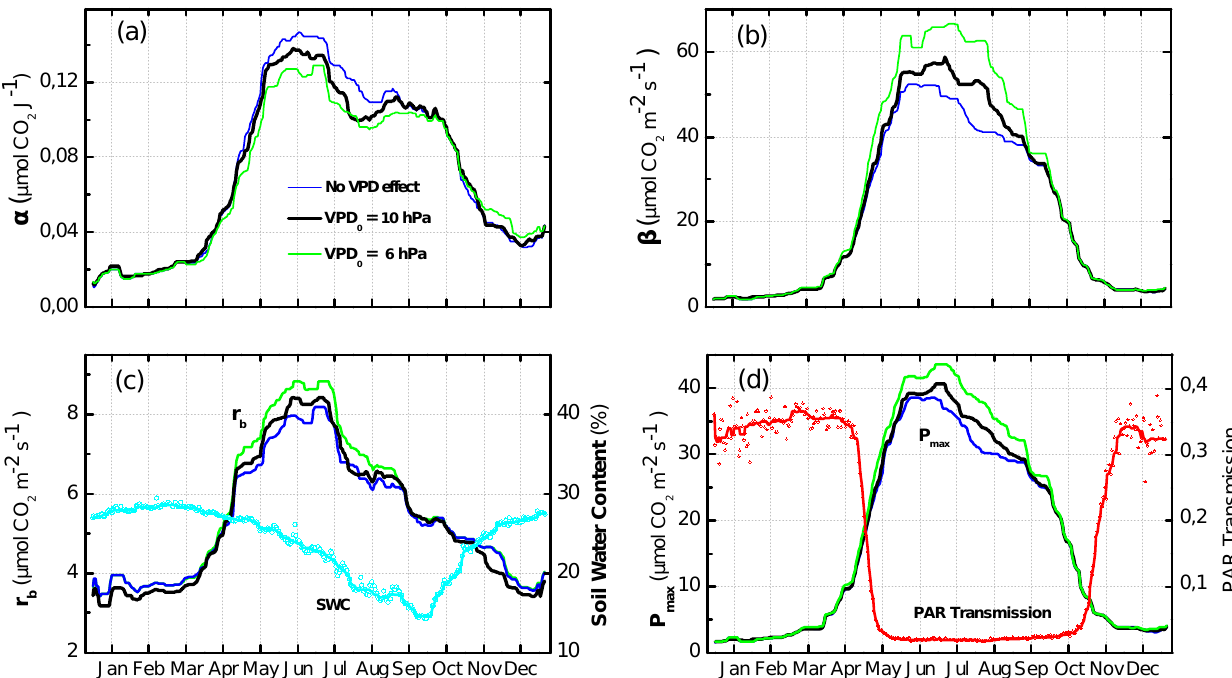
Fig. 5. Seasonal variation in (a) : light use efficiency ( α ), (b) : canopy maximum photosynthetic capacity ( β ), (c) : base respiration ( r b and soil water content, (d) canopy photosynthesis at light saturation ( R g = 1000Wm − 2 ), P max and PAR transmission records from Pilegaard et al. (2011). The blue line (a, b, d) represents the estimated parameter values when the VPD effect (Eq. 4) on β was removed; the green line represents the result when VPD 0 was set to 6 hPa. The parameter time series and P max were presented as an ensemble (mean value) of all the 13yr. PAR transmission data are the ensemble mean from 2001–2009 (measurements began in 2001). The symbols represent mean values and were smoothed with a 14-day median filter (solid